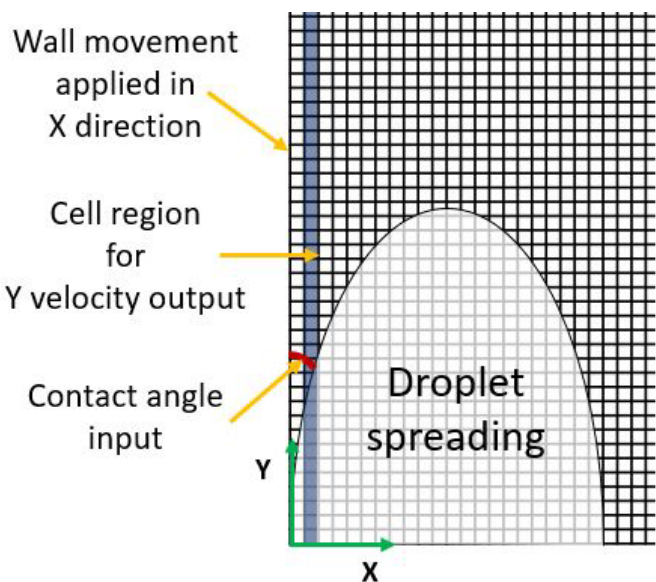
Figure 2. Schematic showing the user-defined function (UDF) inputs and outputs.